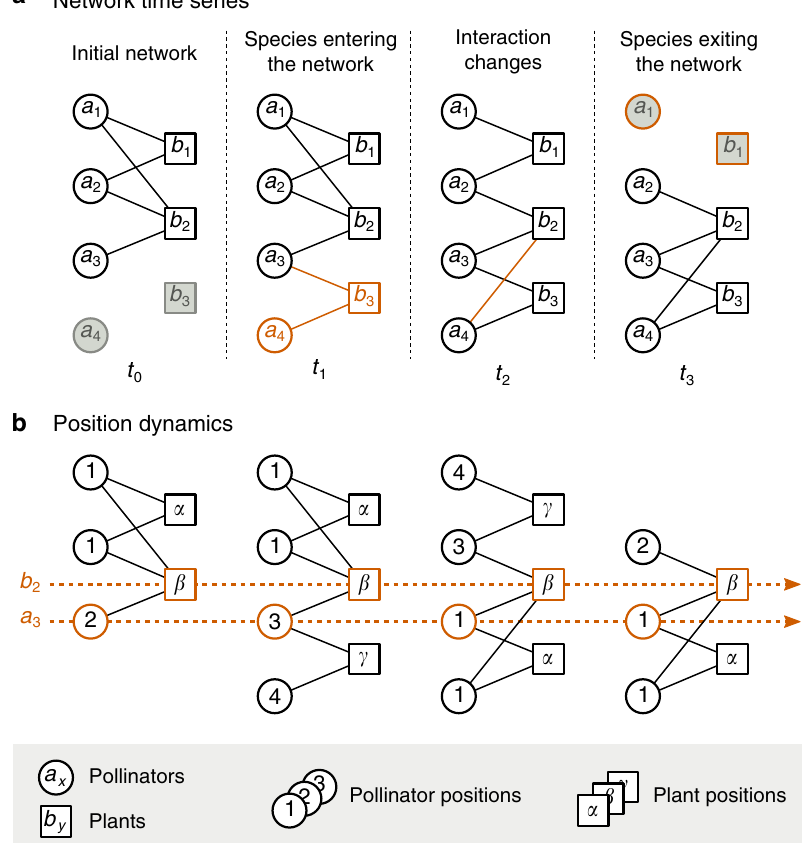
Fig. 1 Dynamics of a bipartite network. a An example of a time series for a plant-pollinator network. The circles and squares represent pollinators and plants, respectively. The links characterize interactions between these species. The colored species and links identify the changes made to the network over time. b The change in species' positions in the network time series represented in a . The different numbers describe different pollinator positions, and the different Greek letters describe different plant positions. The colored dotted lines indicate the position of two speci fi c species a 3 and b 2 . On the one side, species a 3 change its position over time, starting in position ‘ 2' and ending up in position ‘ 1'. On the other, species b 2 preserves the same position ' β ' over time. Note how several species can have the same position in the network.